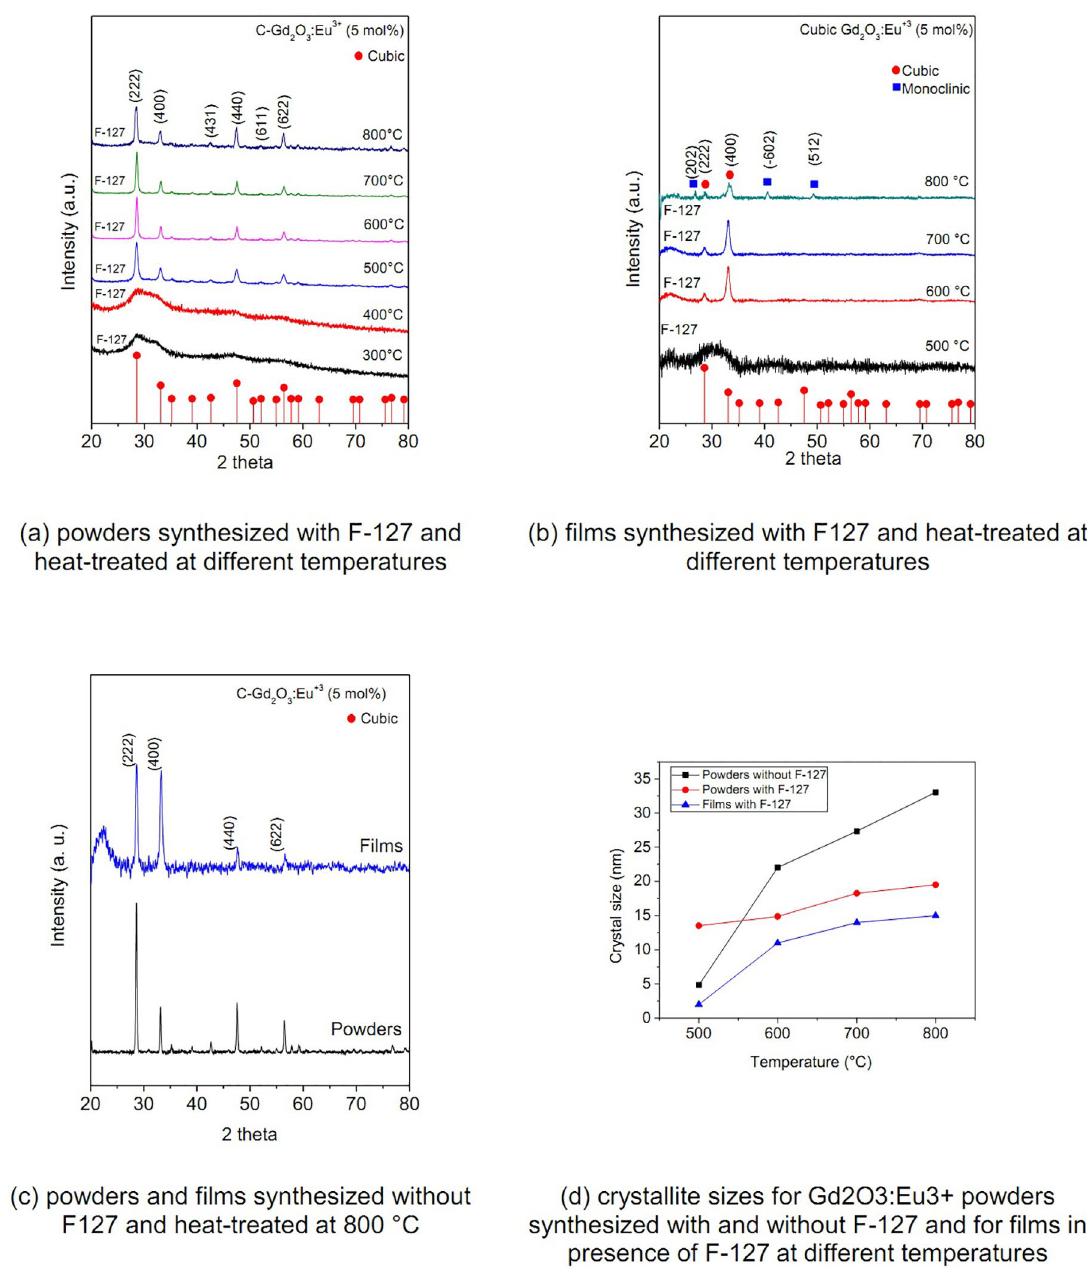
O :Eu 3+ (a) powders, (b) films synthesized with F127 and heat-treated at different temperatures, 2 3